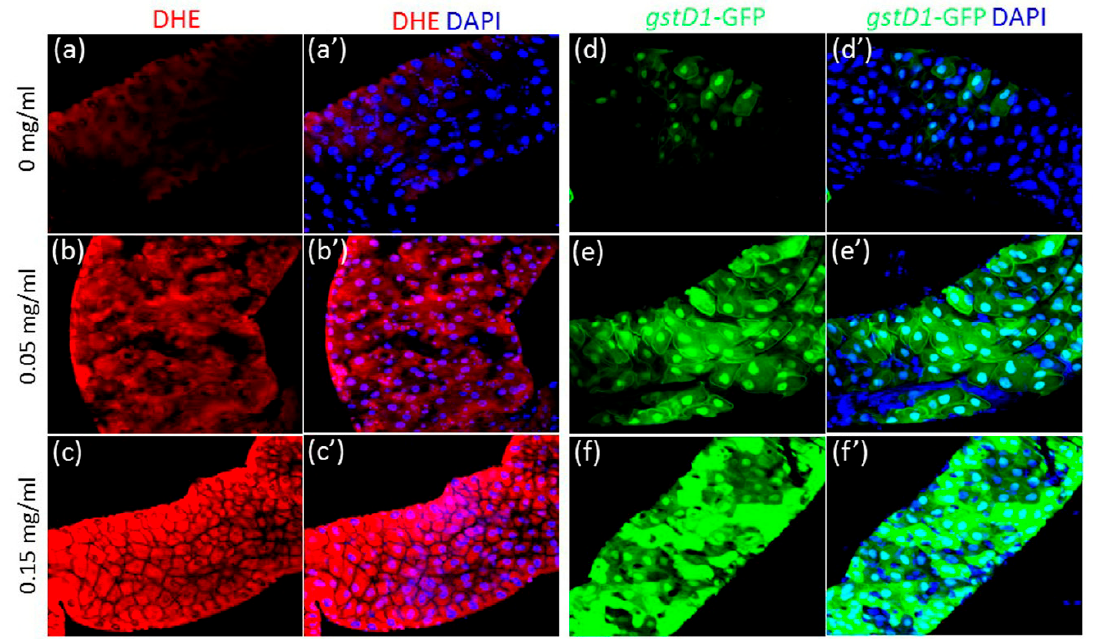
Figure 5. CuONPs induce excessive reactive oxygen species (ROS) production in the gut. Flies were exposed to CuONPs at the concentration of ( a , a’ , d , d’ ) 0 mg/mL, ( b , b’ , e , e’ ) 0.05 mg/mL and ( c , c’ , f , f’ ) 0.15 mg/mL. ( a , a’ ) Dihydroethidium (DHE) staining that detects superoxide levels shows the basal levels of ROS in the control gut epithelial cells. ( b , b’ , c , c’ ) ROS levels become gradually increased upon CuONPs in a dose-dependent manner. Transgenic flies carrying the oxidative stress reporter gene GstD1-GFP were used to monitor the effects of CuONPs on intracellular ROS induction. ( d , d ’) The control gut shows weak GFP expression. ( e , e’ , f , f’ ) GFP expression is dose-dependently increased upon CuONPs.